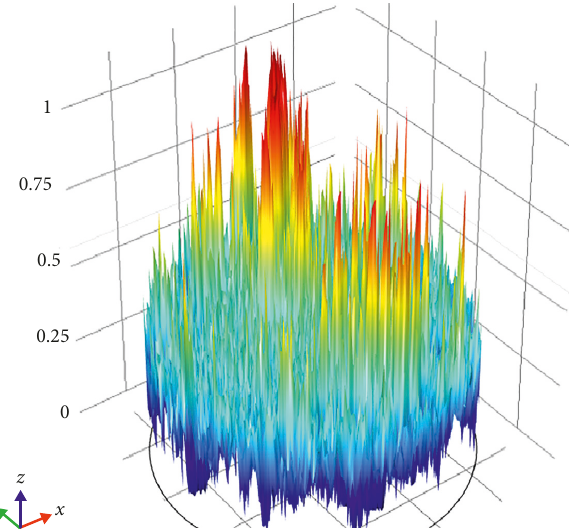
Figure 6: Greyscale value function image of soil-rock mixture.